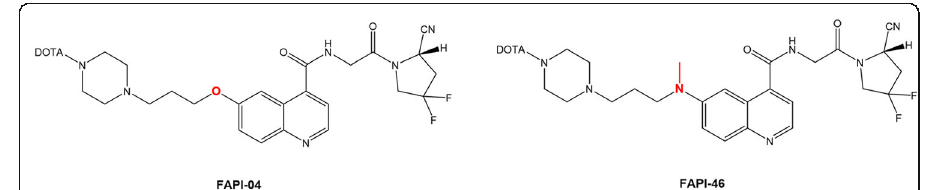
Fig. 1 Structure of FAPI-04 (molecular weight: 872.9288g/mol) and FAPI-46 (molecular weight: